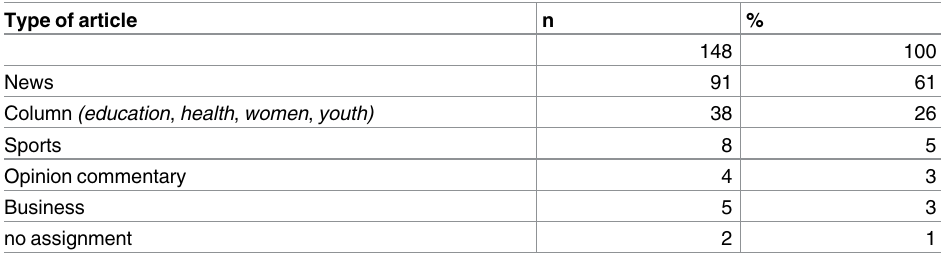
Table 2. Type of publication in the daily